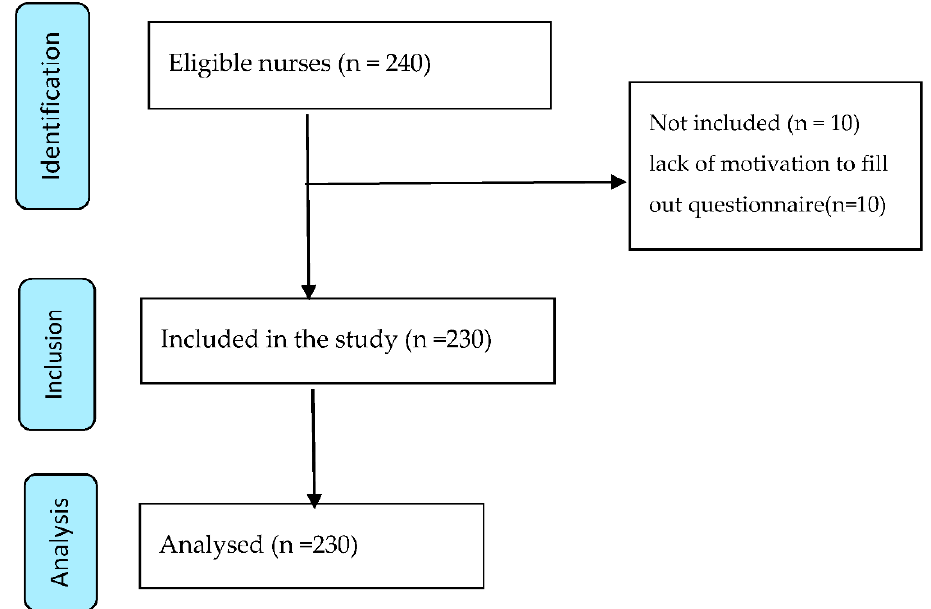
Figure 1. Flow diagram of the selection of study based on STROBE.